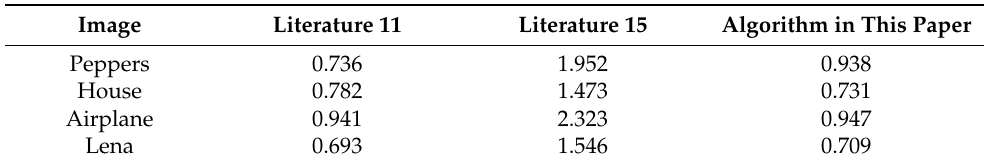
Table 3. Comparison of the running time of the algorithm in this paper and the literature [11,15] for three images segmentation/s.